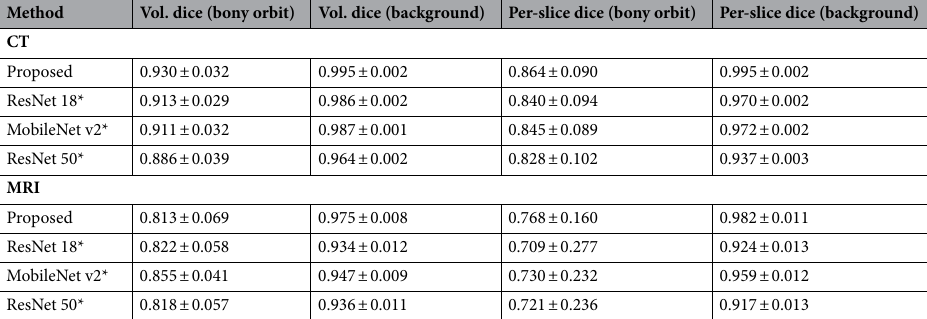
Table 4. Results summary with the mean ± standard deviation for volumetric and per-slice Dice scores for the CT and MRI datasets. The values represent the final ensemble deep learning model and are based on majority voting. Models with an asterisk (*) are based on a DeepLab v3 + convolutional neural network for semantic image segmentation with a specific pretrained model.